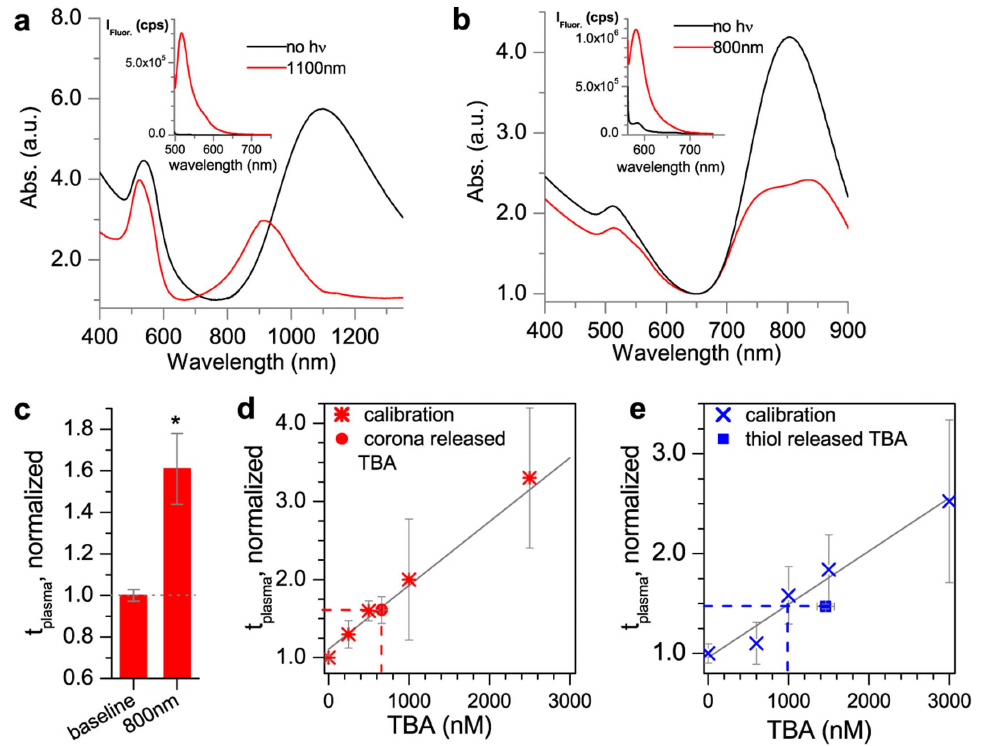
Figure 3. Release from NR- and NB-coronas and their comparison to covalently loaded NRs. a) Absorption spectrum of NB-HS-TBA before (black) and after (red) 1100 nm irradiation, where [NB-HS-anti] =0.3 nM, and released [anti] =129 6 5 nM (430 6 17 anti released/NB). Inset: fluorescence spectrum of released TBA before (black) and after (red) 1100 nm irradiation. b) Absorption spectrum of NR-HS-TBA before (black) and after (red) 800nm irradiation where [NR-HS-TBA] =2.9 nM, and released [TBA] =663 6 23 nM (223 6 8 DNA released/NR). Inset: fluorescence spectrum of released TBA before (black) and after (red) 800 nm irradiation, c) Effect of the released TBA in blood. Comparing normalized t plasma from released TBA from the coronas [NR-HS-TBA]=2.9 nM (red), where released [TBA]=663 6 23 nM in a clotting test. Supernatant of NR-HS-TBA with exposed to no irradiation and added to blood is defined as t plasma =1.0 (gray dotted line). A significant difference (p # 0.05) from baseline t plasma is indicated with a * (Table S1), d) t plasma (normalized) calibration curve of free TBA in a thrombin test (stars). Released TBA from NR-HS-TBA (red circle) and extrapolated equivalent concentration (red dashed line). e) t plasma (normalized) calibration curve of free thiolated TBA (blue X’s). Released thiolated TBA from NR-thiol-TBA (1460 6 108 nM, blue square) and extrapolated equivalent concentration (blue dashed